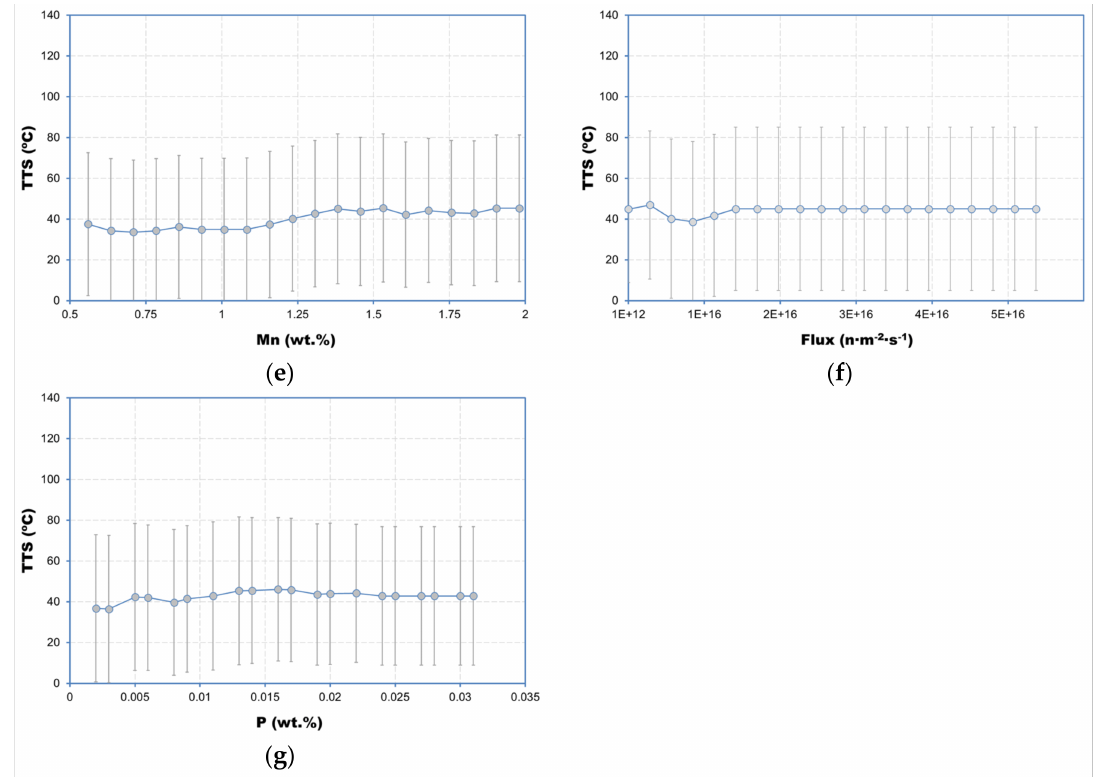
Figure 11. ICE plots showing the impact of each of the features of interest on the TTS. ( a ) Cu, ( b ) Fluence, ( c ) Ni, ( d ) Temperature, ( e ) Mn, ( f ) Flux and ( g )